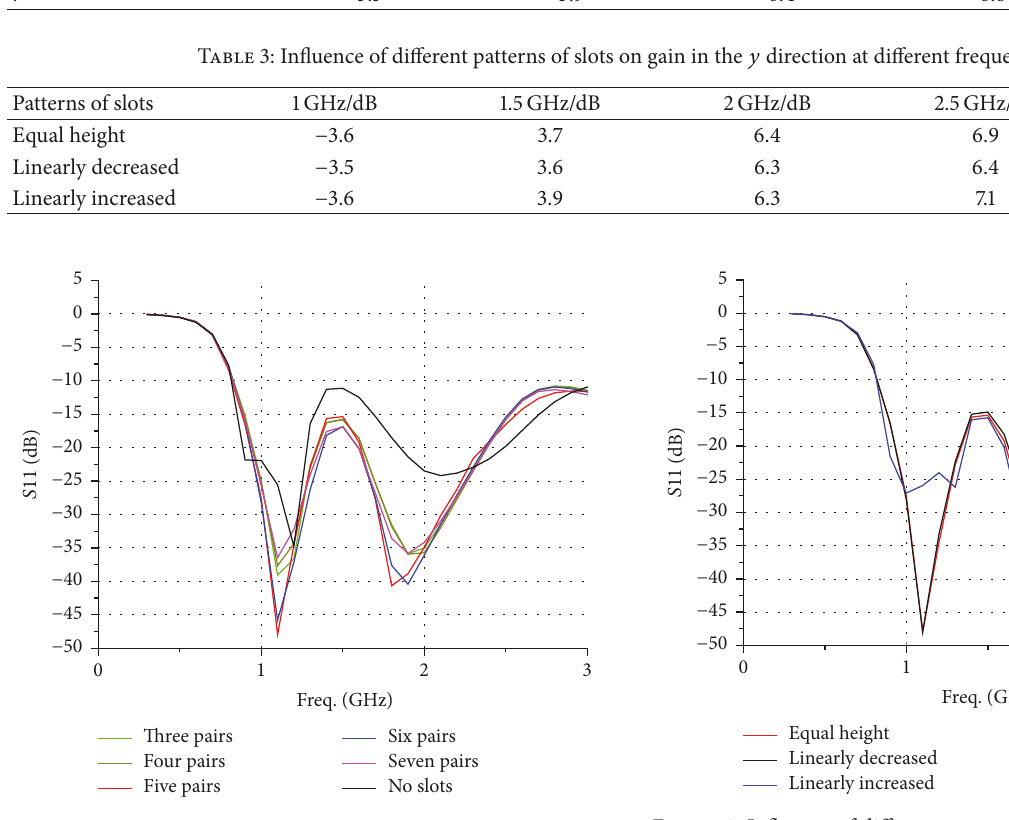
Figure 8: Influence of different patterns of slots on the return loss of the